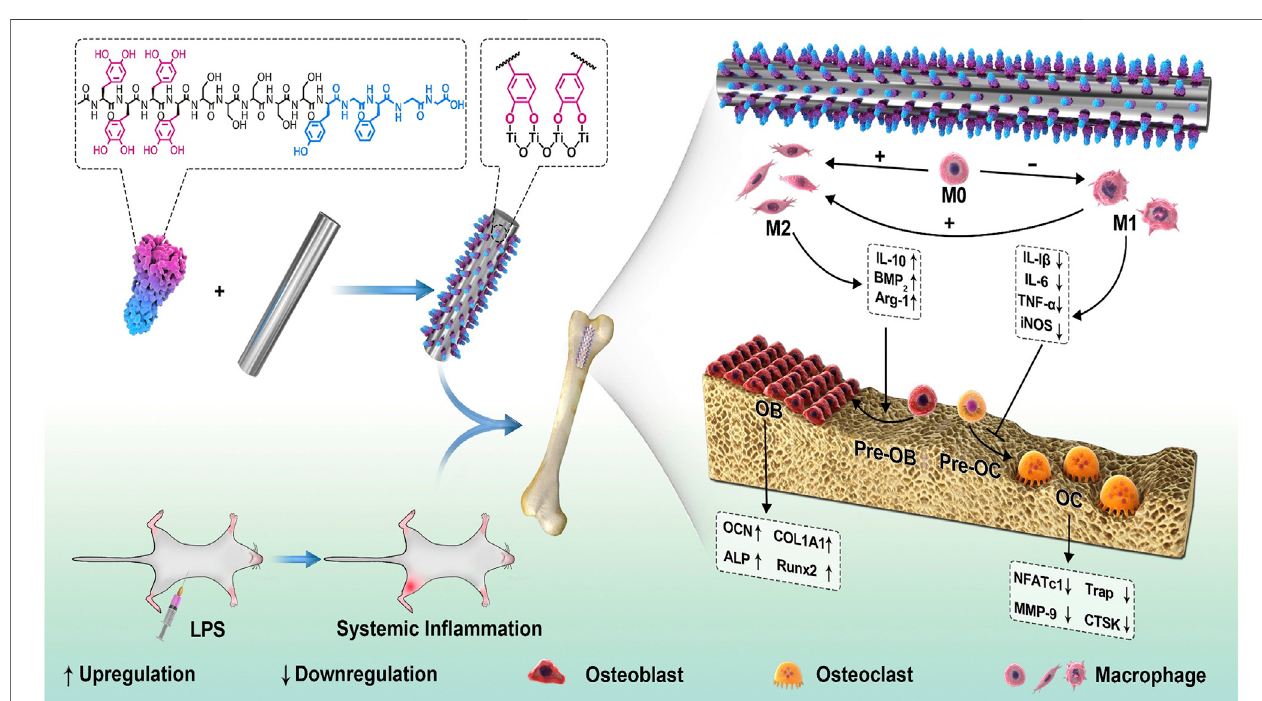
FIGURE 8 | Schematic illustration for the effect of immunomodulation on osteogenesis via the PDA-based peptide-loaded coating. The peptide binds steadily to the Ti implant with the assistance of PDA. Under the LPS-induced in fl ammatory conditions, the biomimetic osteogenic peptide coating exhibited antiin fl ammatory property and changed the macrophages to the M2 phenotype, which in turn enhanced new bone formation (Bai et al., 2020). Copyright 2020, Elsevier.